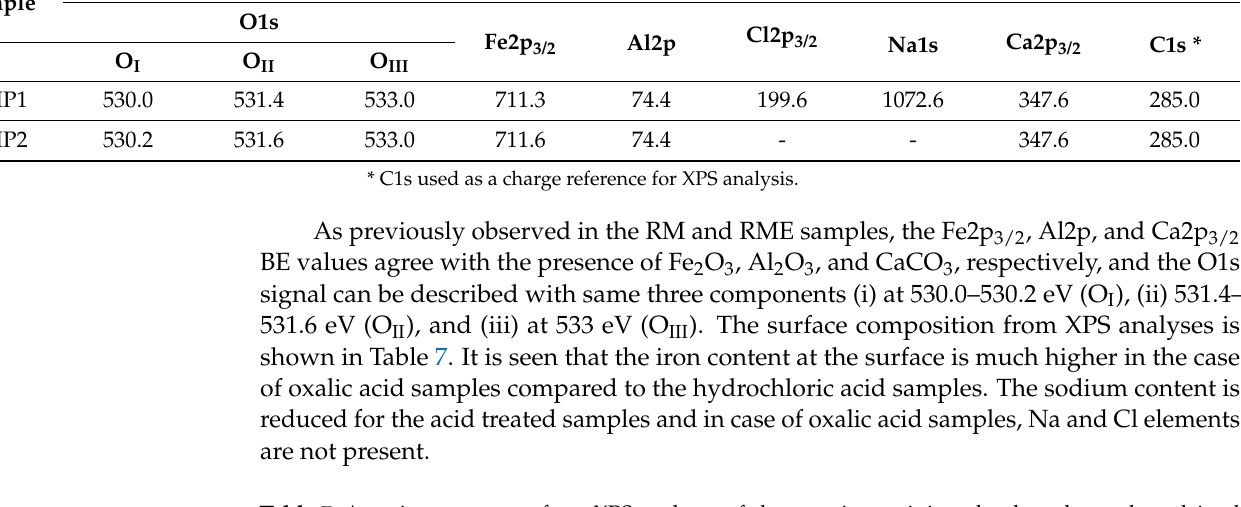
Figure 8. X-ray diffraction patterns of RMP samples calcined at 500 °C and 700 °C. The values of the binding energies of the electrons coming from different orbitals from XPS analysis are shown in Table 6. Table 6. Binding energies of electrons coming from different core levels in precipitated red mud samples calcined at 500 °C. Sample